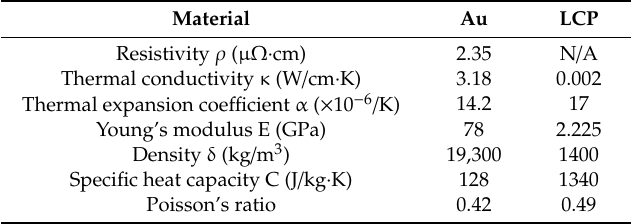
Table 1. Material characteristics of the spring-like double-clamped beam switch.